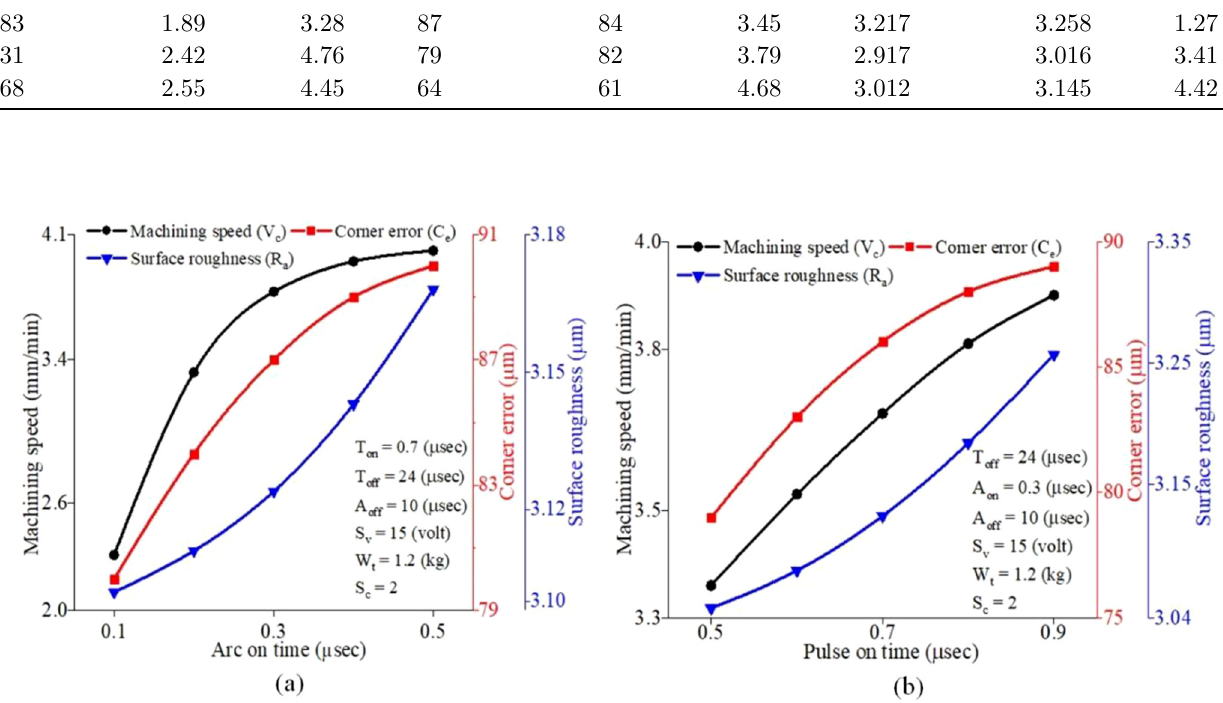
Fig. 3. Effect of (a) arc on time (b) pulse on time and on machining speed, corner error and surface